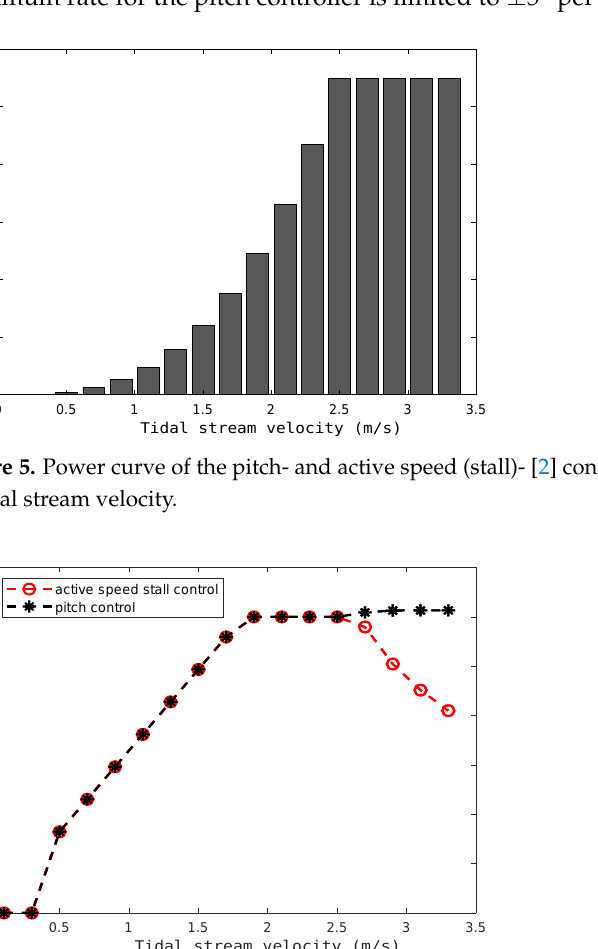
Figure 6. Speed curves of the pitch- and active speed (stall)- [2] controlled tidal turbines as a function of the tidal stream